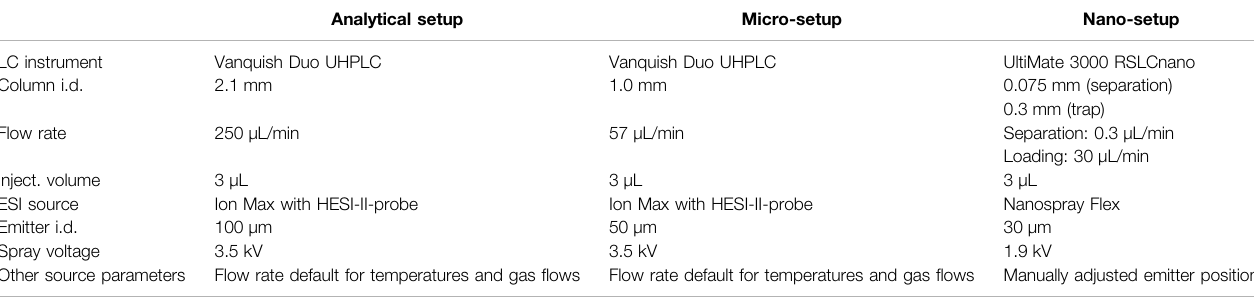
TABLE 1 | Key features of the three analytical